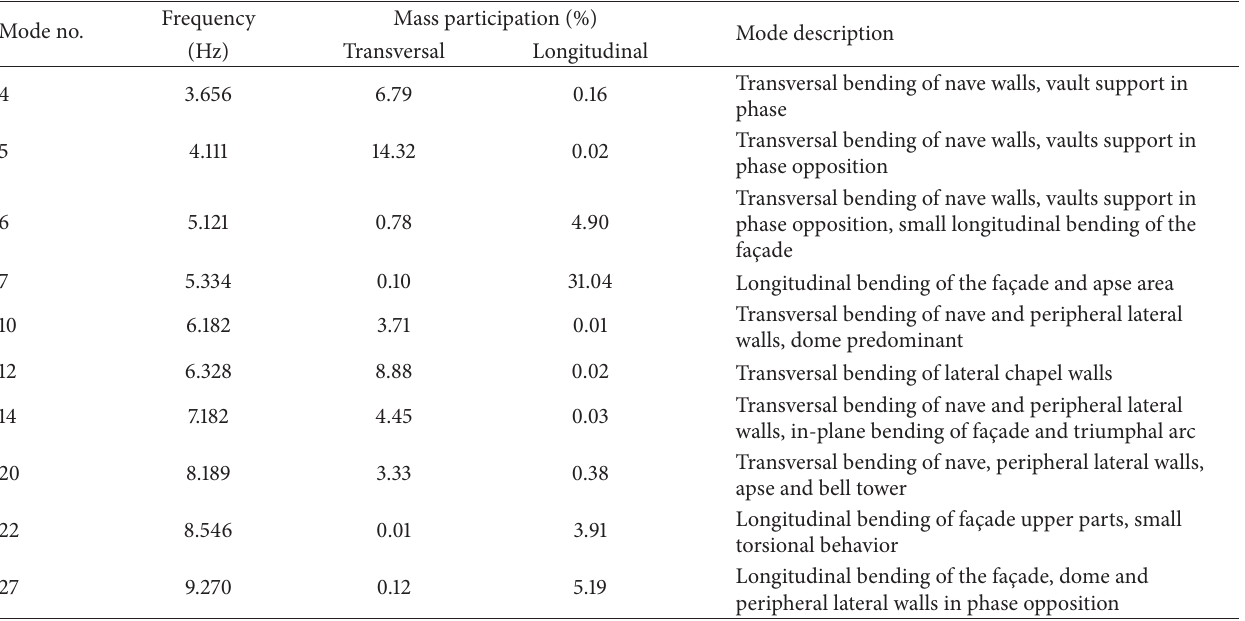
Table 1: Linear dynamic analysis: frequencies of the main mode shapes of the St. Maria del Borgo Church (bell tower modes are not reported in the present table). Mode